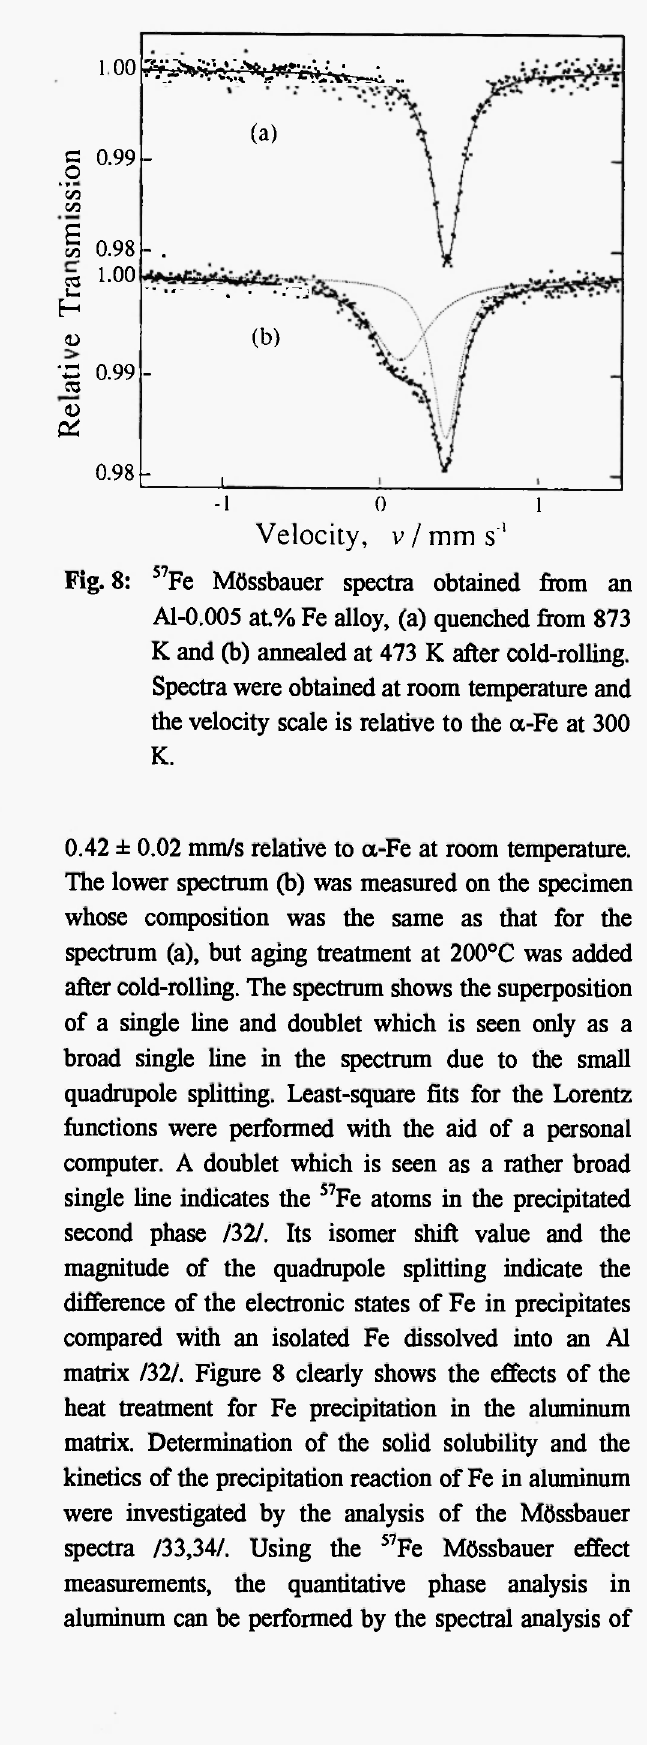
Fig. 8: 57 Fe Mössbauer spectra obtained from an Al-0.005 at% Fe alloy, (a) quenched from 873 Κ and (b) annealed at 473 Κ after cold-rolling. Spectra were obtained at room temperature and the velocity scale is relative to the α-Fe at 300 K.